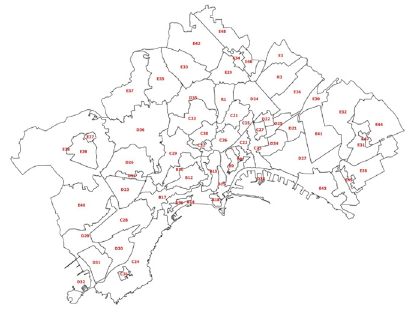
Figure 3: Median real estate values.